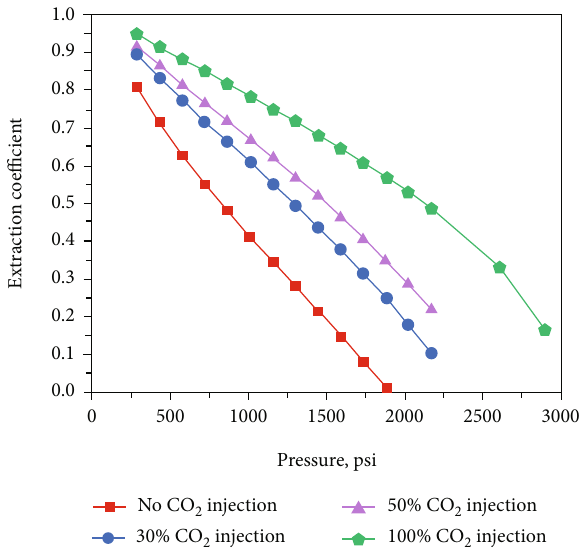
Figure 16: Extraction coe ffi cient of lighter hydrocarbons for the Bakken tight oil versus pressureat various CO